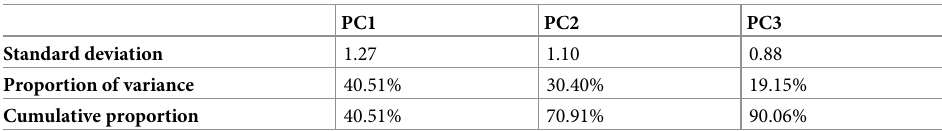
Table 2. Table of principal